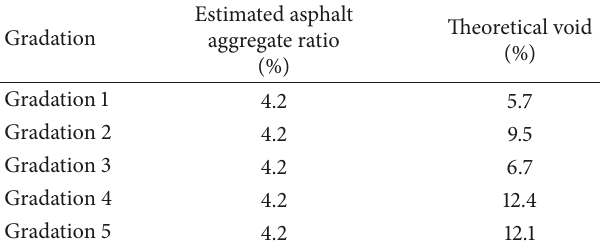
Table 7: Theoretical void of each